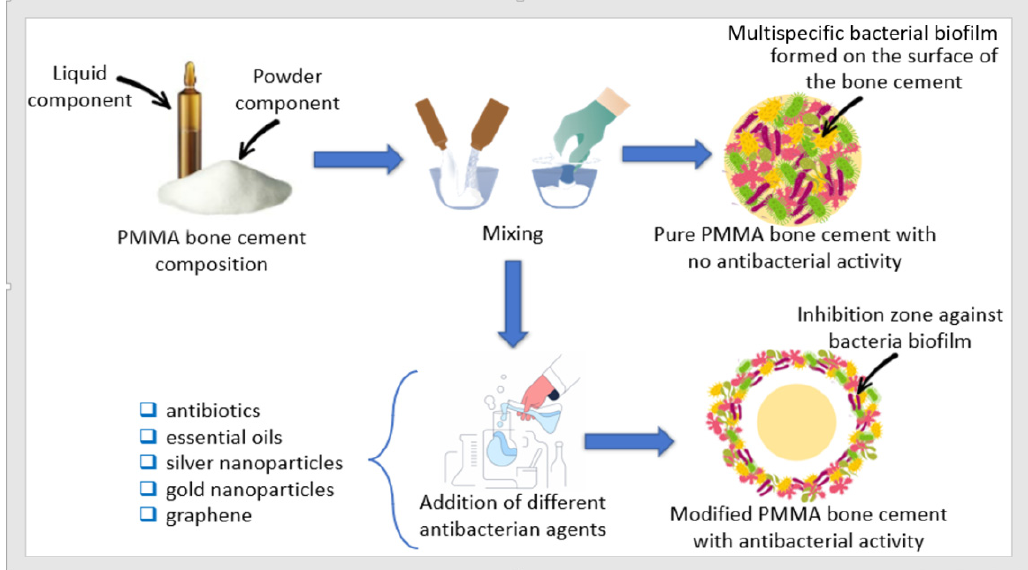
Figure 1. Schematic representation of the modified PMMA bone cements preparation procedure with antibacterial properties.